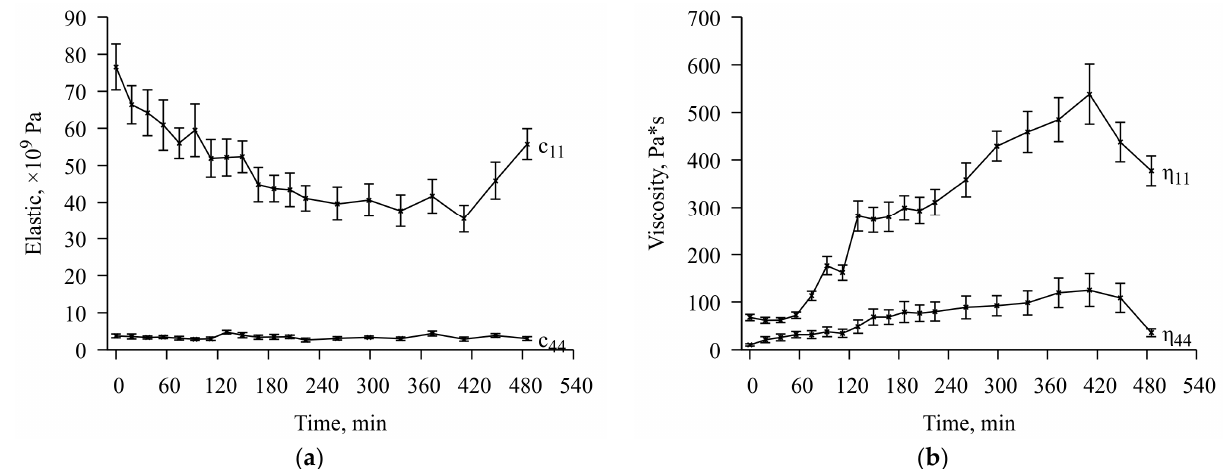
Figure 9. The results of fitting the mechanical material constants of the chitosan acetate film from the run time of the experiment. ( a ) elastic moduli; ( b ) viscosity moduli.